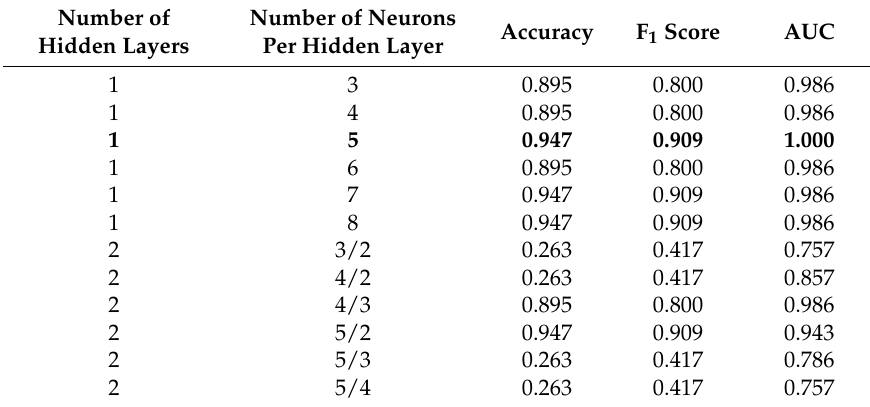
Table 4. Hyperparameter tuning of artificial neural network training.